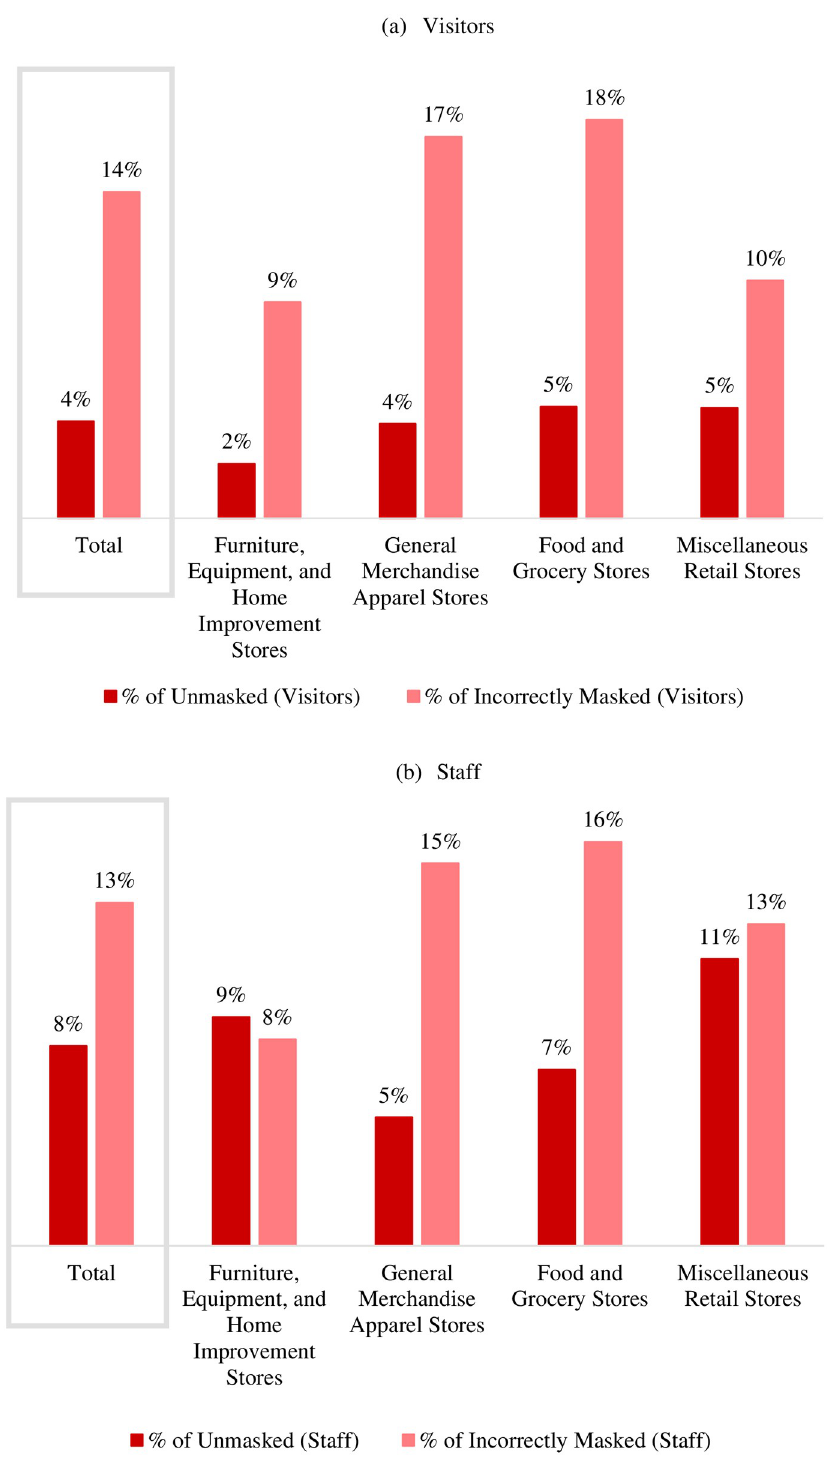
Fig 2. The average prevalence of the unmasked and improperly masked among visitors and staff of Louisville indoor public areas by retail trade group, Dec. 14–20, 2020.